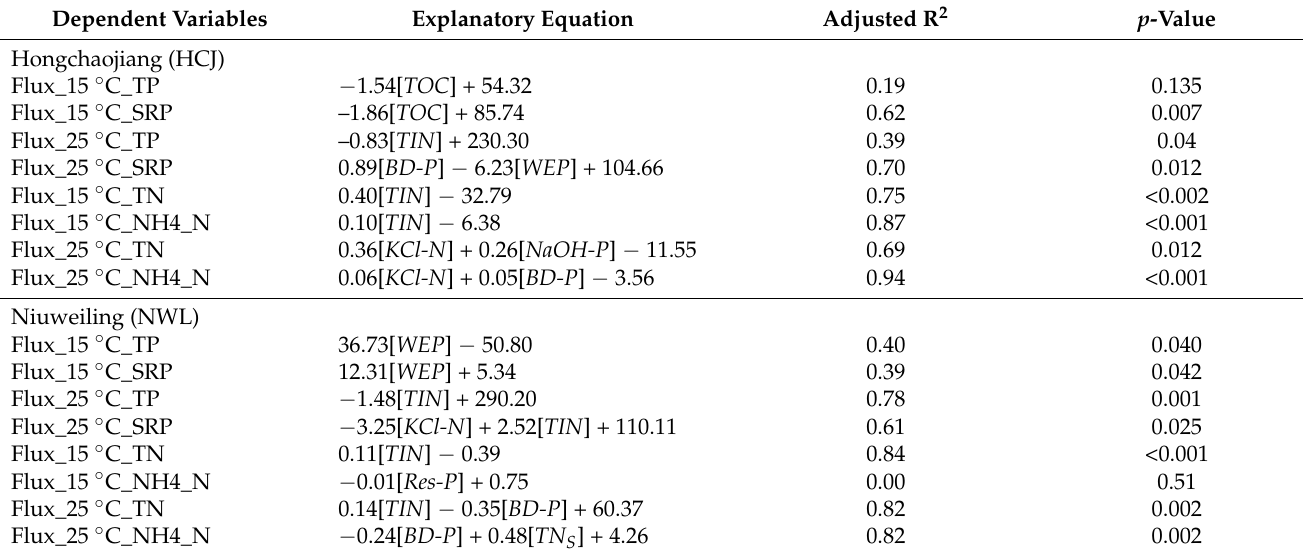
Table 3. Stepwise multiple linear regression (MLR) used to identify the primary controlling factors of sediment properties for apparent fluxes of dissolved total P (TP), soluble reactive P (SRP), total N (TN), and ammonium (NH 4 -N) during the 20-day incubation at 15 ◦ C and 25 ◦ C. Parameters are listed in descending order of the absolute value of the Pearson correlation coefficients between the explanatory factors and dependent